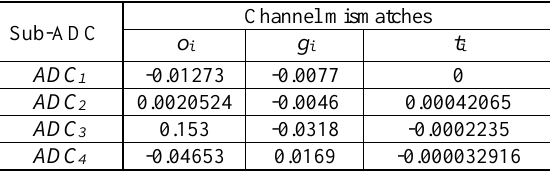
Table 1. The table of channel mismatch